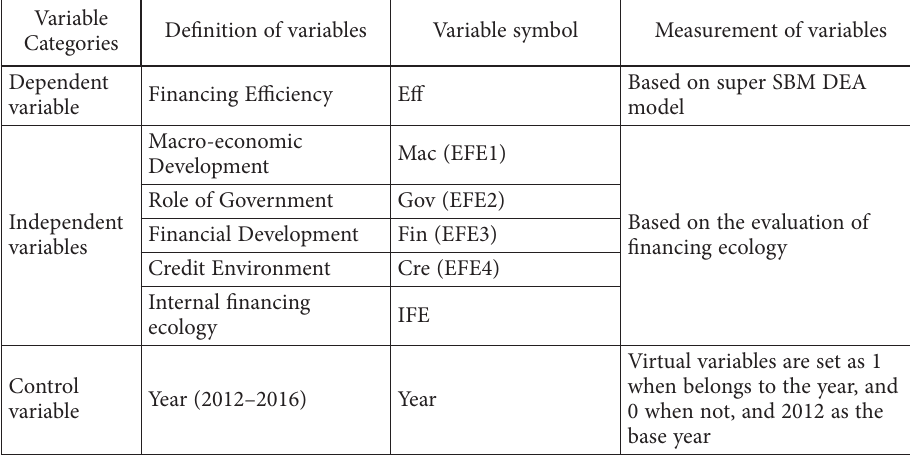
Table 5. Definition and measurement of variables Variable